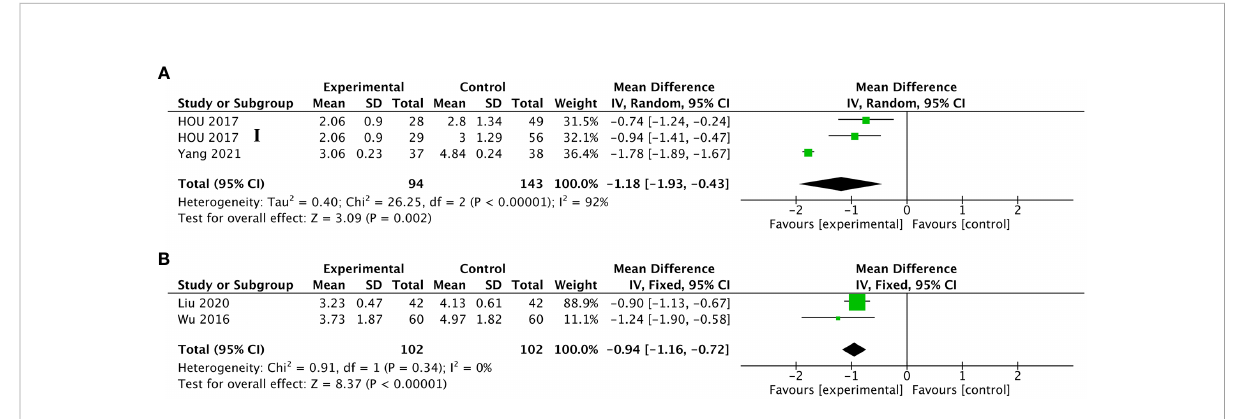
FIGURE 5 Forest plot of the fatigue in lung cancer patients treated with acupuncture and control. (A) The changes measured by the Revised Piper Fatigue Scale (PFS-R) in lung cancer patients undergoing chemotherapy treated with acupuncture-related intervention versus control from the baseline to the end of treatment; (B) the changes measured by PFS-R in lung cancer patients with cancer-related fatigue treated with acupuncture- related intervention versus control from the baseline to the end of treatment. IV, inverse variance; CI, con fi dence interval. The Roman numerals “ I ” , followed by the study ID, represented the comparison of acupuncture versus no intervention in the study that had three